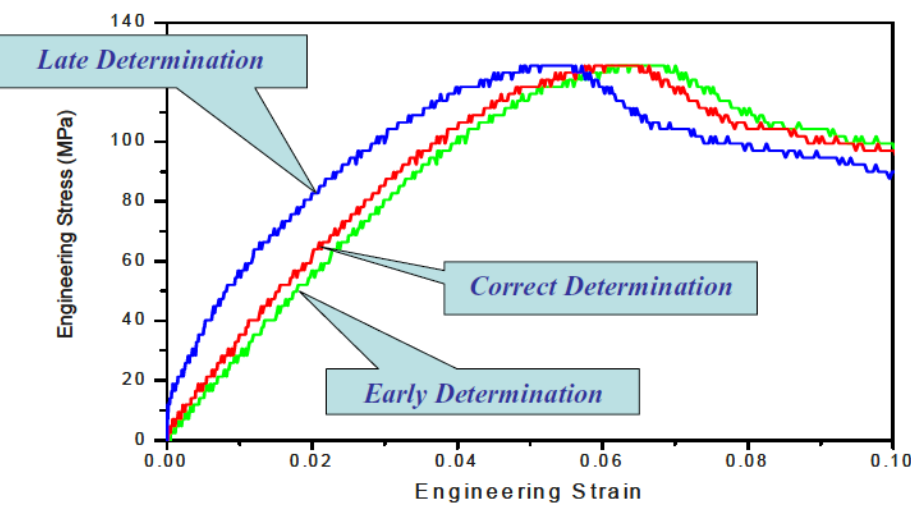
Figure 8. Determination of stress-strain curves, the correct and incorrect method. Reprinted with permission from Springer, Split Hopkinson (Kolsky) Bar by Chen and Song (2011) [14].